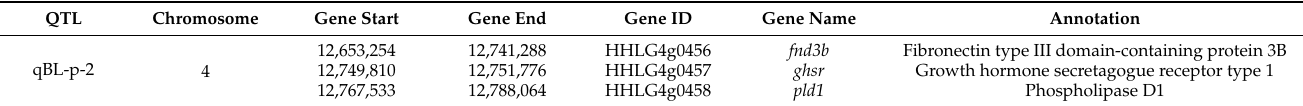
Table 7. Candidate genes related to major effect QTLs in Yellow River carp at 5–9 months after